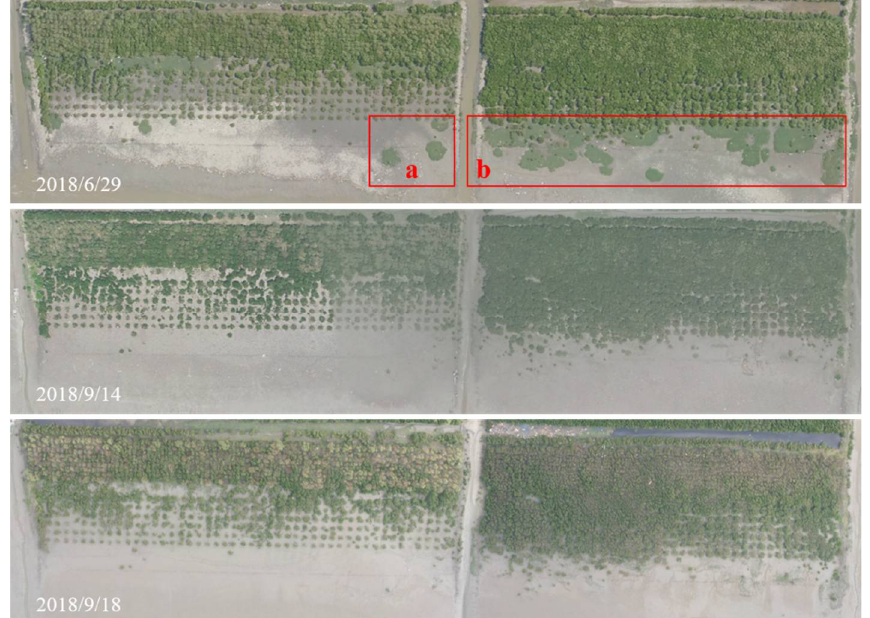
Figure 8. Aerial photos indicate accretion in the front region of the mangrove (correspond to the dashed yellow-line bounded area in Figure 1c) on June 29 ( top ), September 14 ( middle ), and September 18 ( bottom ). Two examples in the red boxes a and b showed that severe sedimentation buried the salt grasses grow along with the mangrove seedlings, with the clearer comparison shown in Figure 9 and Figure 10, respectively.